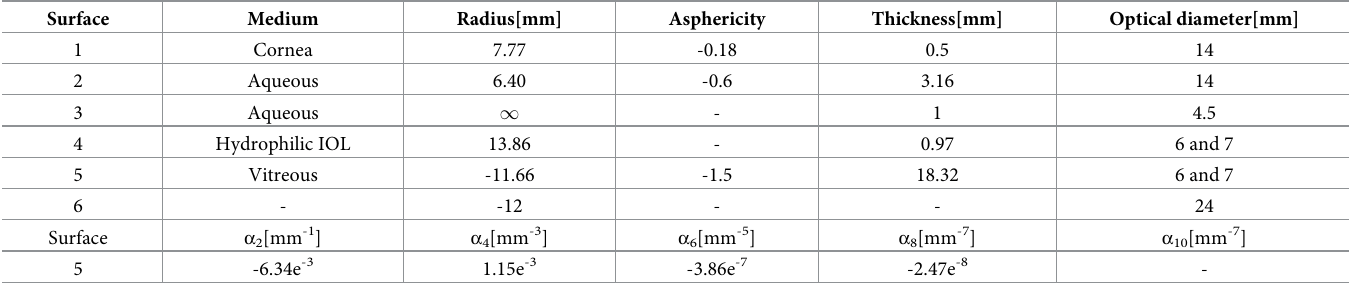
Table 1. Structural parameters of the pseudophakic eye model.